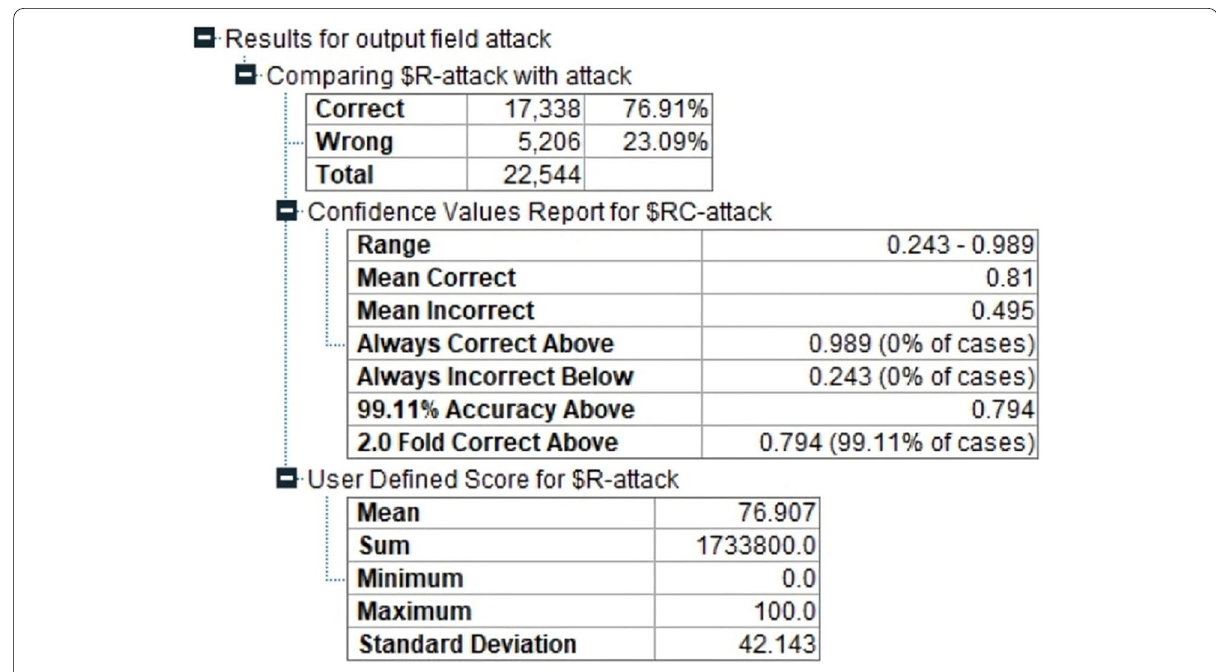
Fig. 14 Accuracy level in CHAID model